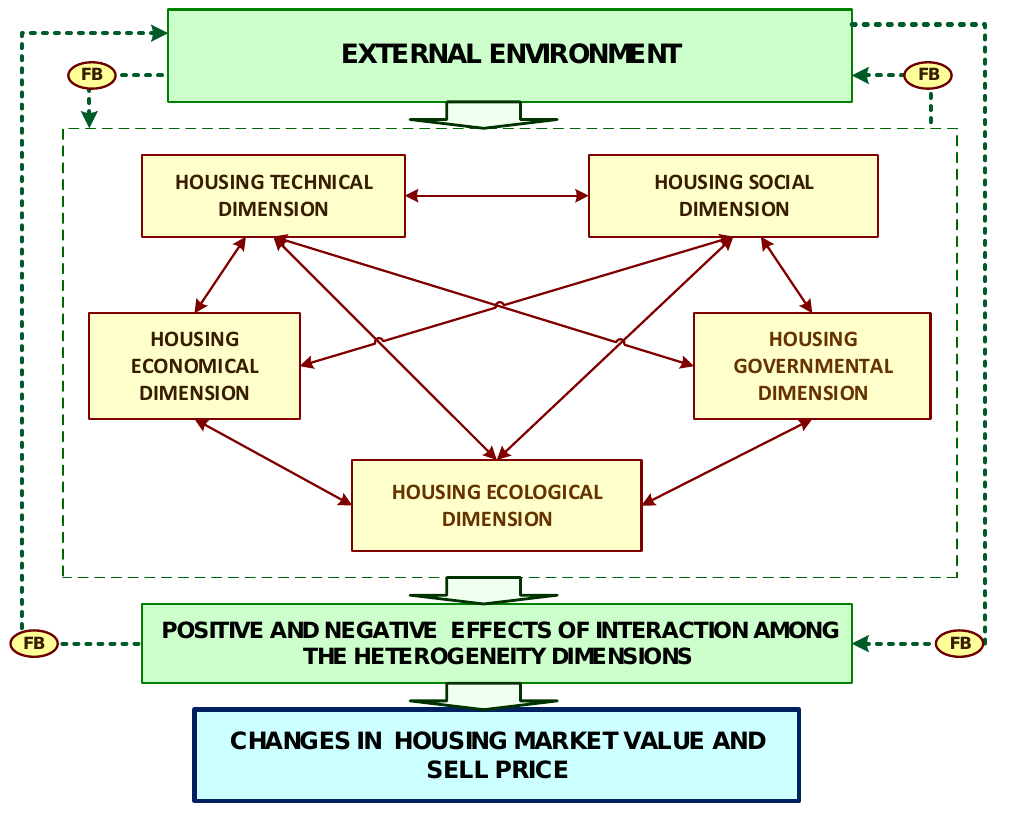
Fig. 2. The model of the effects of the interaction among the constituent dimensions of housing heterogeneity (Figure developed by the